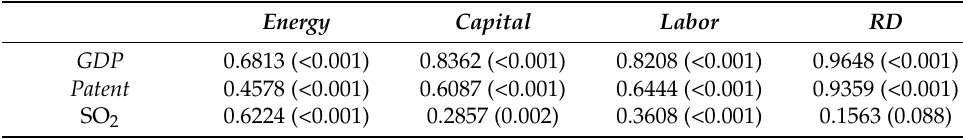
Table 2. Correlation coefficients between outputs and